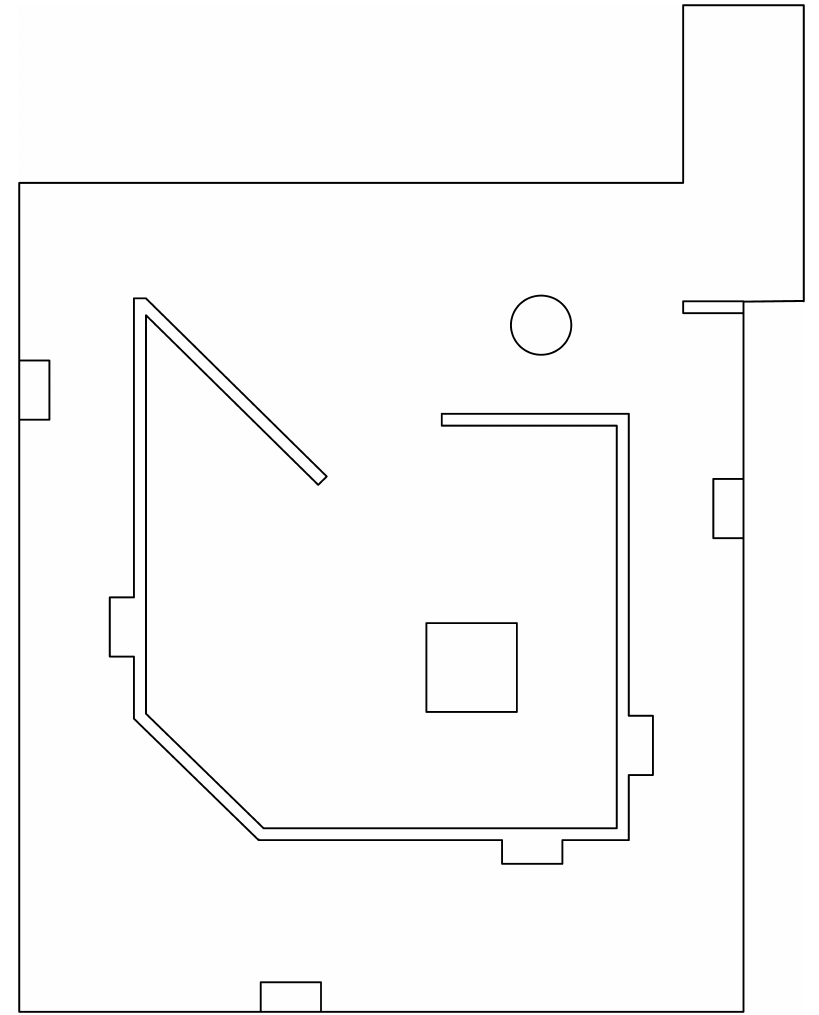
Figure 2. Training